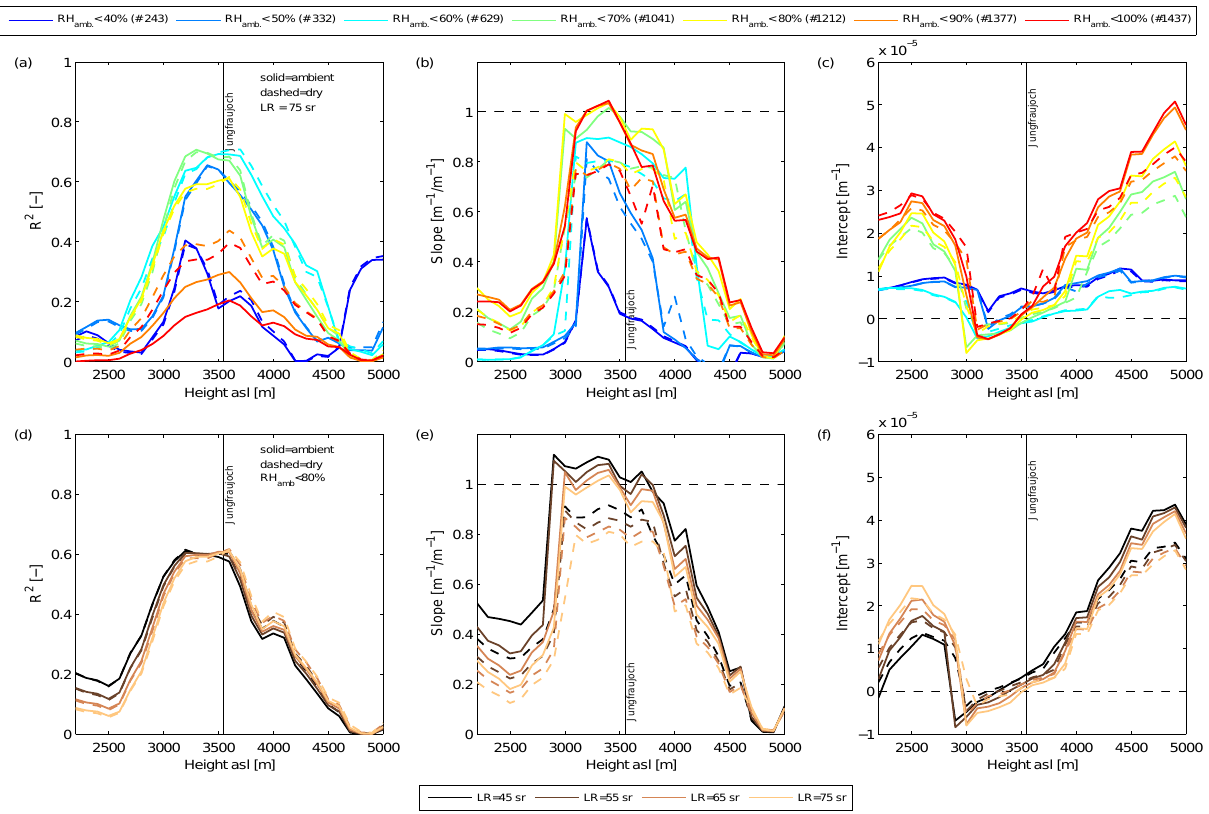
Fig. 6. Comparison of the aerosol extinction coefficient retrieved from the LIDAR measurements and in-situ measurements. The measure- ments from the Jungfraujoch station (at 3580m a.s.l.) were brought to ambient conditions (solid lines) and are compared to the LIDAR measurements at different heights (100m averages). The corresponding dry in-situ measurements (dashed lines) are shown as well. (a) Cor- relation coefficient for LR = 75sr where the data is categorized by the ambient relative humidity RH (see legend above, number of points is given in brackets), ( b and c ) Slope and intercept of a weighted linear least squares fit for the same categorization as in panel (a) . (d) Correlation coefficient for all measurements and different LR with RH amb < 80%, ( e and f ) Slope and intercept for the same group of points as in panel (d)